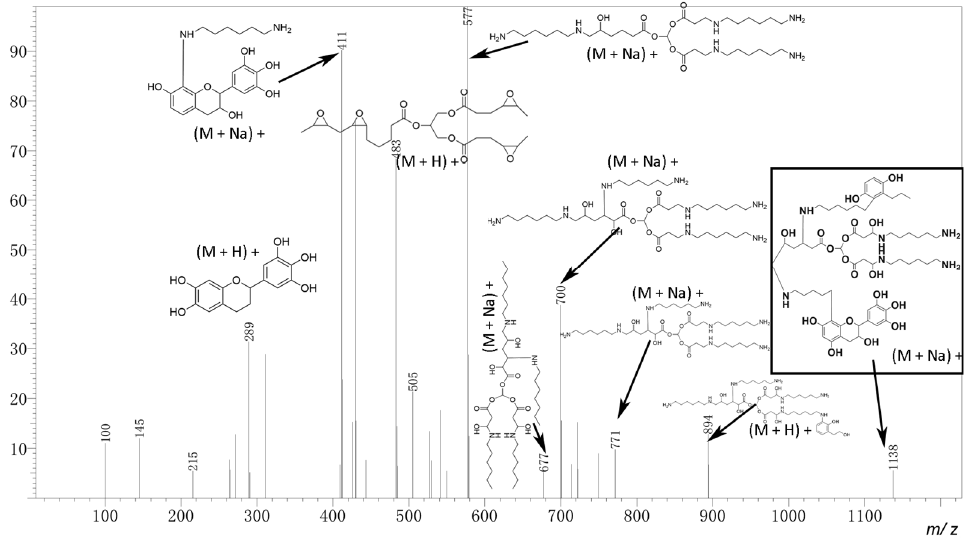
Figure 2. ESI-MS spectra of the tannin-epoxidized soybean oil-hexanediamine (TEH) resin.